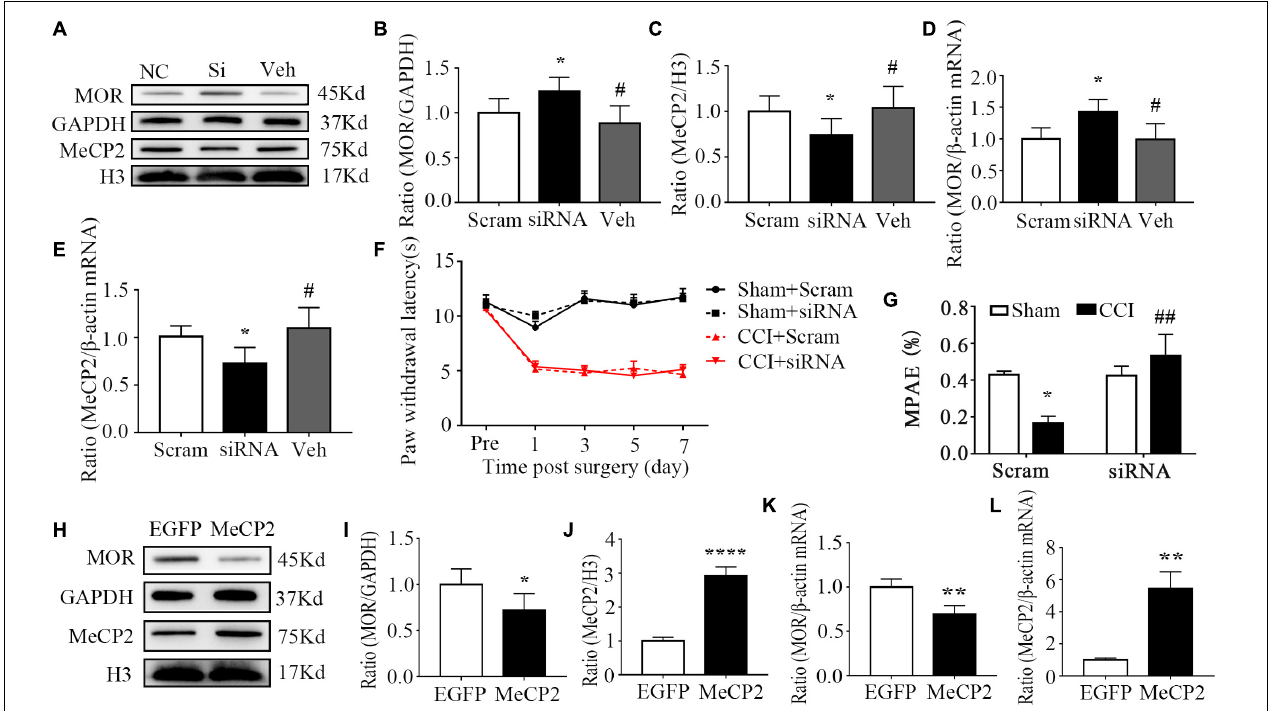
FIGURE 4 | MeCP2 regulated MOR expression in the injured ipsilateral DRG. (A–G) The day of surgery was set as day 0. MeCP2 siRNA (100 pmol/10 µ L) was intrathecally infused 30 min before surgery for 4 consecutive days. WB and qRT–PCR were undertaken to analyze the expression of MOR and MeCP2 on day 7. PWL was measured 30 min after morphine injection (1.5 mg/kg, subcutaneous infusion, s.c.) on day 7. (A–C) Levels of MOR and MeCP2 proteins in the ipsilateral L3–5 DRGs on day 7 after CCI surgery in mice pre-treated with MeCP2 siRNA, scramble RNA or vehicle intrathecally for 4 consecutive days. n = 6 biological repeats (18 mice)/group. One-way ANOVA followed by post hoc Tukey test. F group (2, 15) = 6.717 for MOR, F group (2, 15) = 3.991 for MeCP2. * p < 0.05, versus the corresponding CCI plus scramble siRNA group; # p < 0.05, versus CCI plus MeCP2 siRNA. (D,E) Levels of Oprm1 mRNA, Mecp2 mRNA in the ipsilateral L3–5 DRGs on day 7 after intrathecal infusion of MeCP2 siRNA (siRNA), control scrambled siRNA (Scram) or vehicle. n = 4 biological repeats (8 mice)/group. One-way ANOVA followed by post hoc Tukey test. F group (2, 9) = 5.714 for MOR, F group (2, 9) = 5.099 for MeCP2. * p < 0.05, versus the corresponding CCI plus scramble siRNA group. (F) Effect of i.t. MeCP2 siRNA or scramble siRNA on the paw withdrawal latencies (PWL) to heat stimuli on the ipsilateral side at the different days after CCI or sham surgery. n = 12 mice/group. Two-way RM ANOVA followed by post hoc Tukey test. F group (3, 165) = 233.8. (G) MPAE showed that the decreased analgesic effect of morphine was rescued through the treatment of MeCP2 siRNA compared with that in the scramble siRNA group on day 7 in neuropathic pain mice. n = 12 mice/group. Two-way ANOVA followed by post hoc Tukey test. F group (1, 44) = 1.181. * p < 0.05, versus the sham plus scramble siRNA group; ## p < 0.01, versus the CCI plus scramble siRNA group. (H–L) AAV5–MeCP2 or negative control AAV5–EGFP (5*10ˆ 10 VG, i.t.) was used on day 0. WB and qRT–PCR were undertaken to analyze the expression of MOR and MeCP2 on day 36. The levels of MOR protein, MeCP2 protein (H–J), Oprm1 mRNA, and Mecp2 mRNA (K,L) in the L3-5 DRG 36 days after the intrathecal infusion of AAV-EGFP or AAV-MeCP2. n = 6 biological repeats (18 mice)/group in panels (H–J) . * p < 0.05, **** p < 0.0001, versus the negative control EGFP group by two-tailed unpaired Student’s t -test; n = 4 biological repeats (8 mice)/group in panels (K,L) . ** p < 0.01, versus the negative control EGFP group by two-tailed unpaired Student’s t